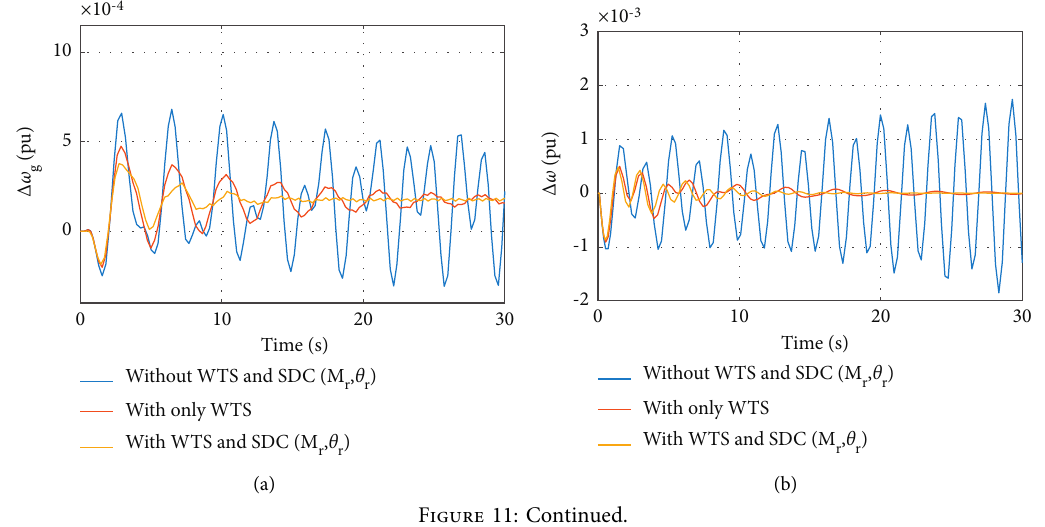
Figure 10: (a) The rotor speed deviation in WPP ( V displacement of rotor in WPP ( V w ≈ 12m/s). (d) The load angle deviation in CPP ( V w ≈ 12m/s). (e) The common terminal voltage ( V w ≈ 12 m/s).